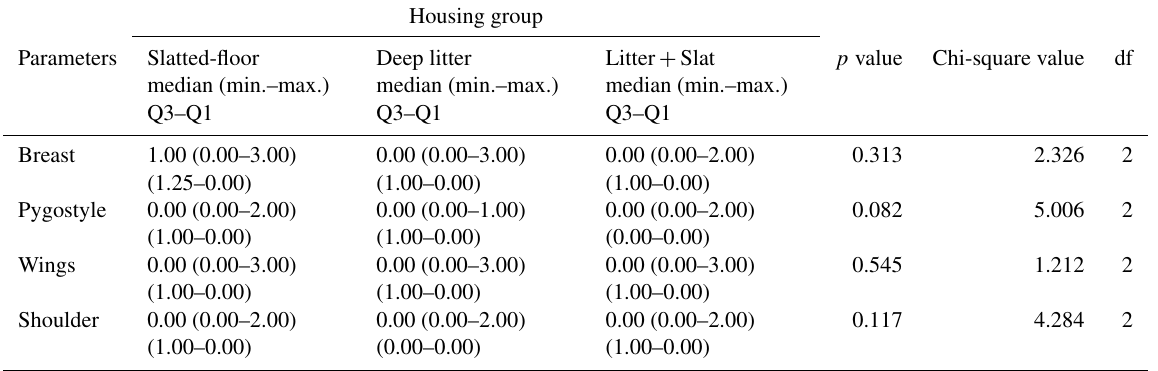
Table 3. Median, minimum and maximum scores ∗ and of the hemorrhage or lesion scores of the breast, pygostyle, wings, and shoulder of broiler carcasses in the